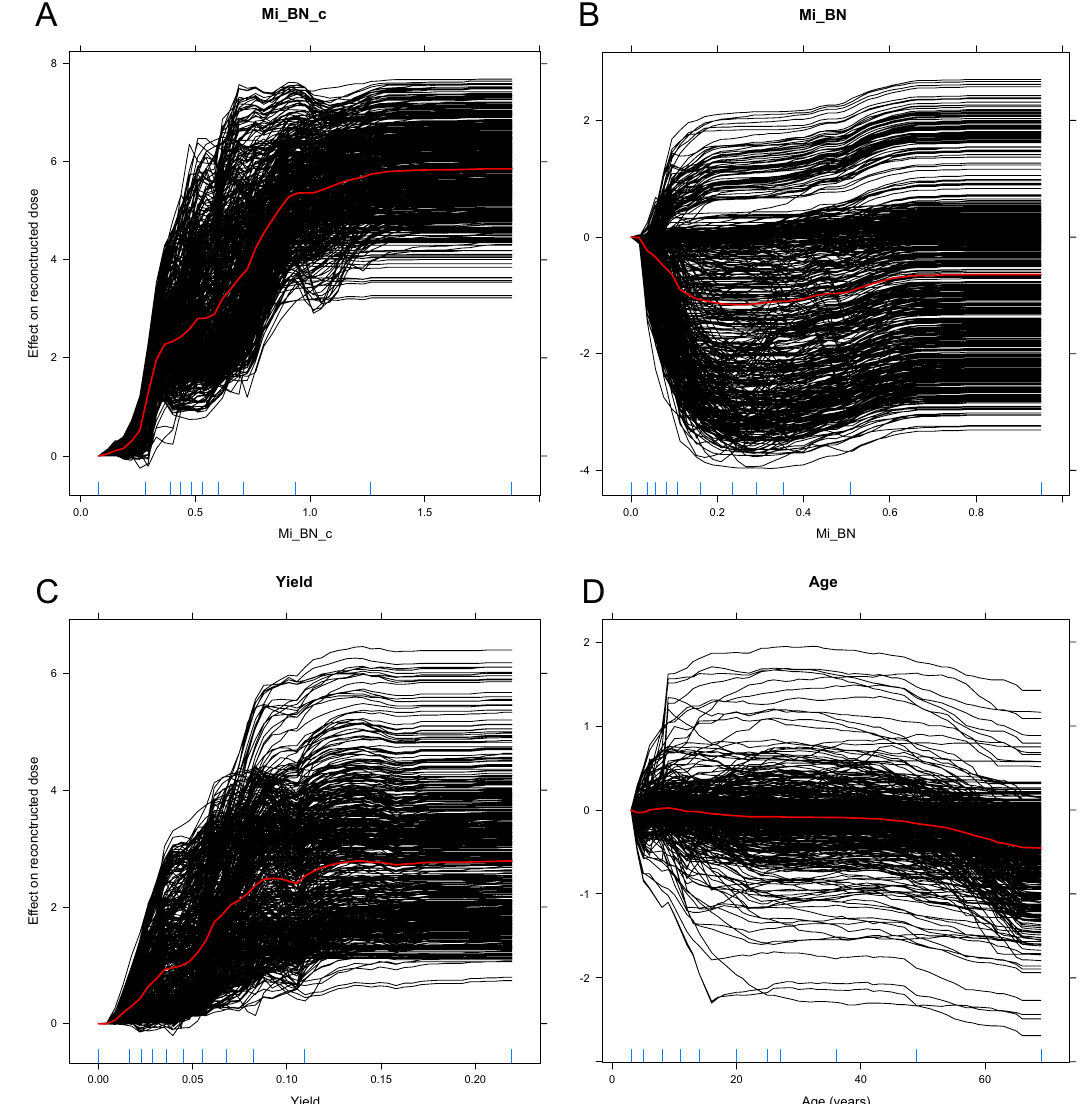
Figure 6. Partial dependence plots, which show the influence of selected predictor variables ( A – D ) on reconstructed dose in the random forest model. Each black curve represents an Individual Conditional Expectation (ICE) plot for a given blood sample (data point), which shows how the reconstructed dose for this blood sample changed when the selected predictor variable was changed along the x-axis. Each red curve represents the average of all black curves in each